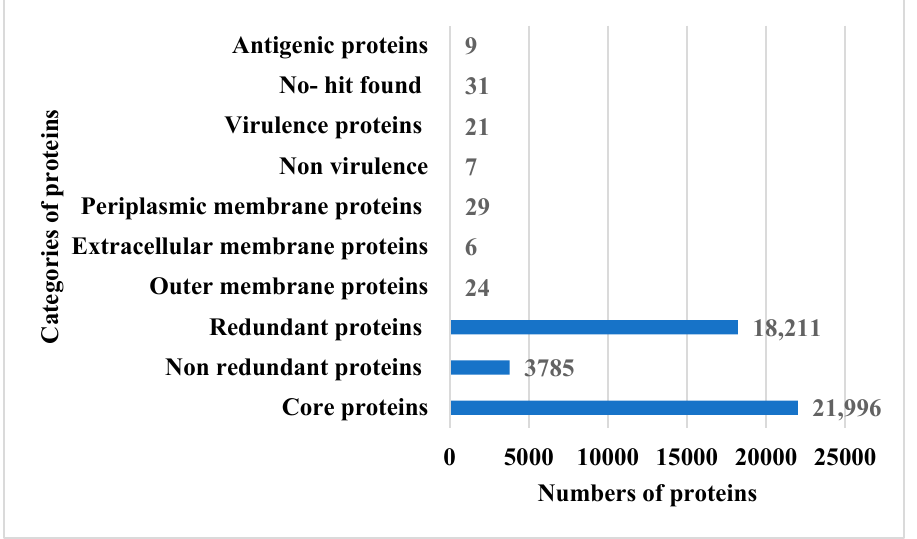
Figure 2. Different categories of proteins achieved in each step of proteome subtraction. It can be noticed that the size of the proteome is reduced by applying different filters, and only 9 appropriate antigenic proteins were prioritized as good subunit vaccine targets.